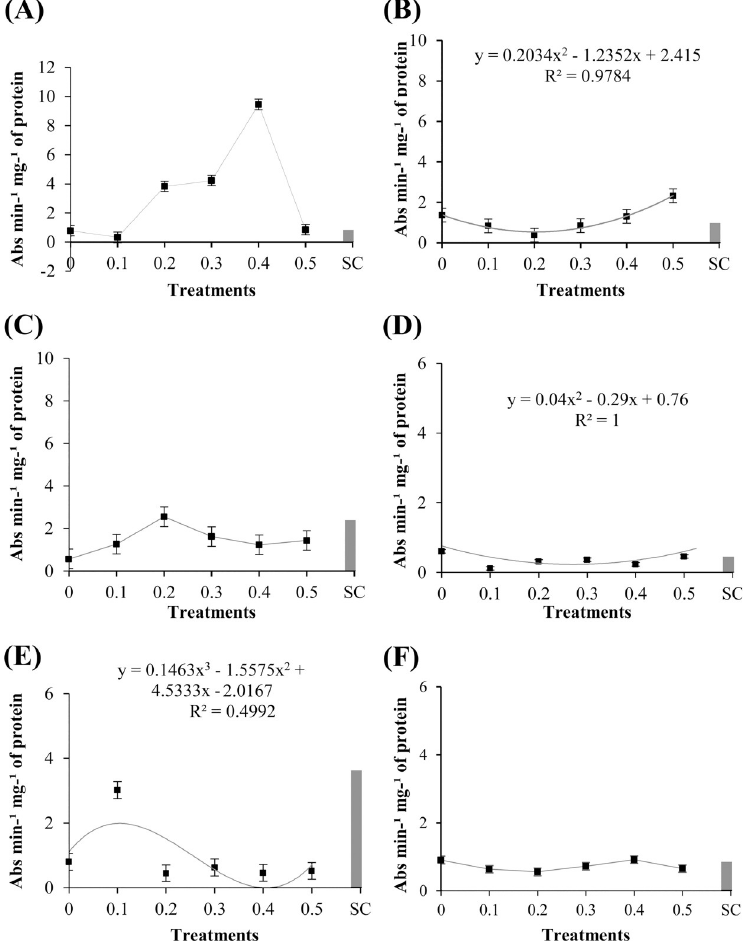
water (0), and S . cerevisiae (SC). Cultivars treated with R . guttatus cutaneous secretions (species 1): ( A ) ‘Monsoy 8372 IPRO’; ( B ) ‘TMG 132 RR’; and ( C ) nontransgenic ‘TMG 4182’. Cultivars treated with R . marina cutaneous secretions (species 2): ( D ) ‘Monsoy 8372 IPRO’; ( E ) ‘TMG 132 RR’; and ( F ) nontransgenic ‘TMG 4182’. Data were the mean of three independent experiments. Data when significant were subjected to regression analysis (P � 0.05), adjusting the regression equations (R 2 ). Treatment with S . cerevisiae was used as an additional control. Metric bars indicate the standard error of the mean (SE).